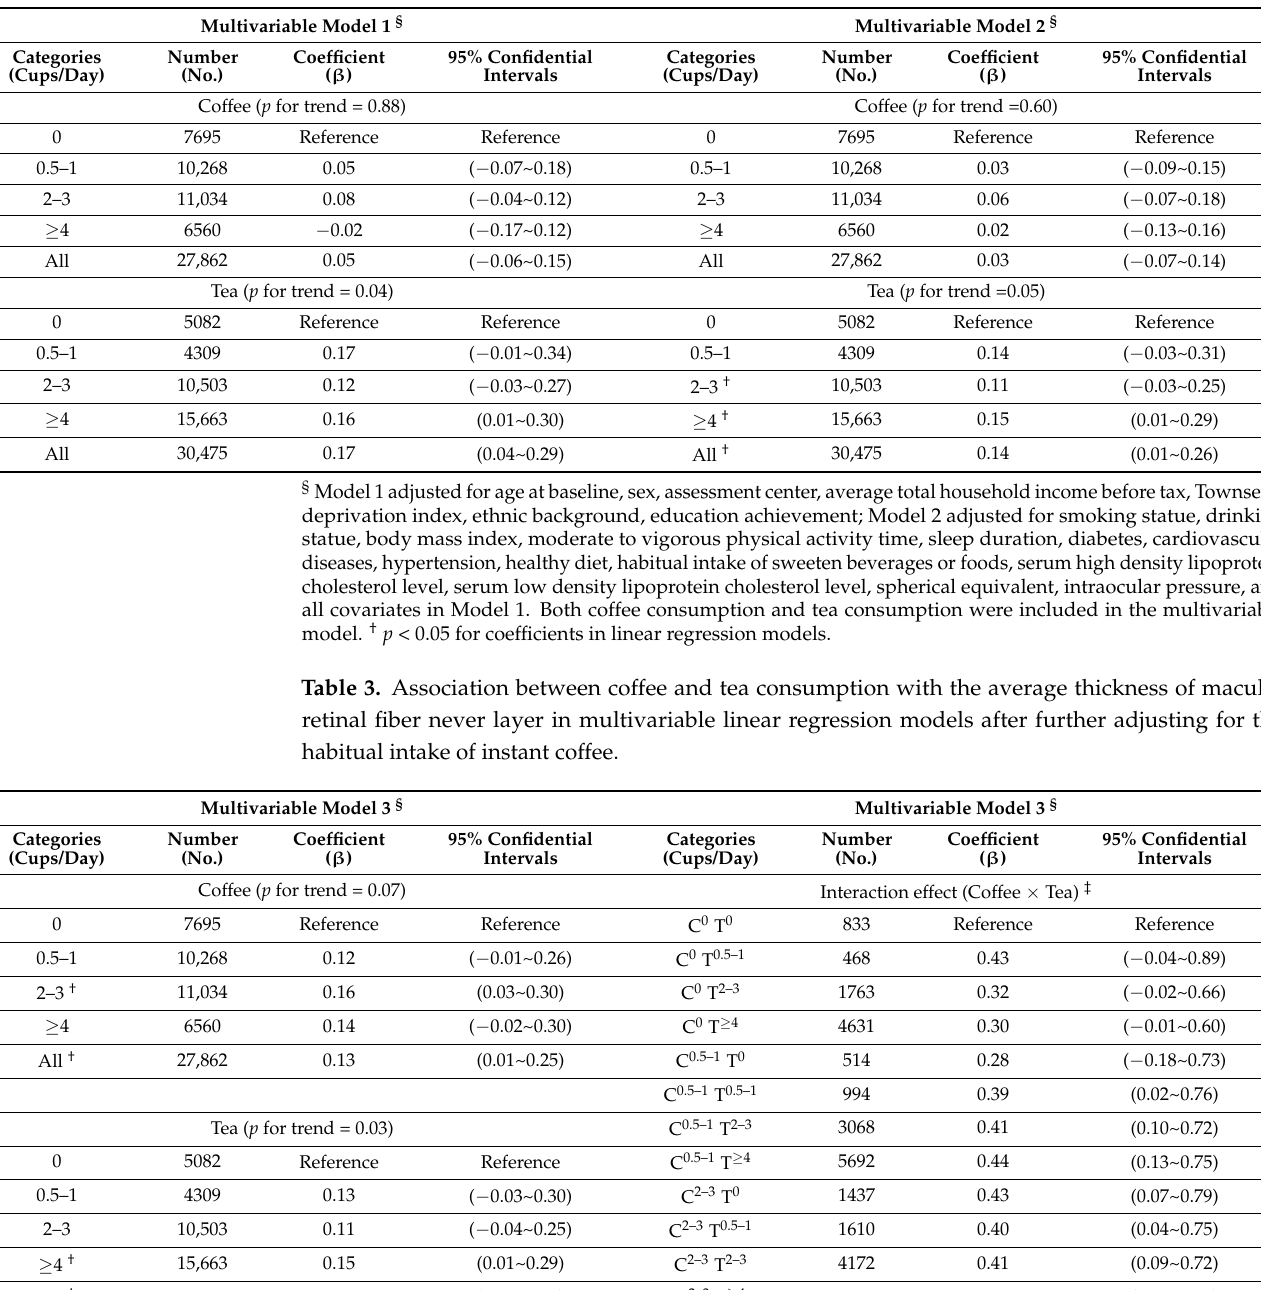
Table 2. Association between coffee and tea consumption with the average thickness of macular retinal fiber never layer in univariable and multivariable linear regression models.